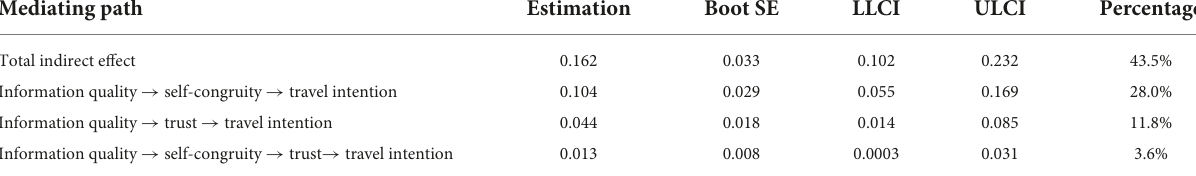
TABLE 5 Mediating effect